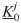
Number of alive (non-empty) groups K¯0j for each chain j for Sim 2.Results are shown for Sim 2, n = 100 (left) and n = 200 (right). Boxplots of the number of non-empty groups K¯0j for each chain j are included; each chain represents posterior samples from the Zmix sampler with the hyperparameter α
j on the mixture weights, the value of which is included in red for each j.